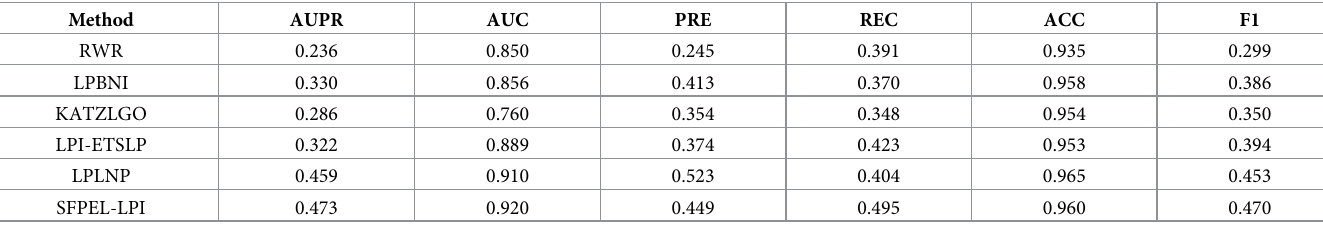
uses three lncRNA features (“interaction profile”, “expression profile”, “sequence composi- tion”) and two protein features (“interaction profile”, “CTD”), while SFPEL-LPI only used lncRNA sequences, protein lncRNAs and known lncRNA-protein interactions. We conduct 20 runs of five-fold cross validation to evaluate methods, and take the paired t- test to analyze difference between SFPEL-LPI and benchmark methods. Table 3 demonstrates Table 2. Performances of prediction methods on the benchmark